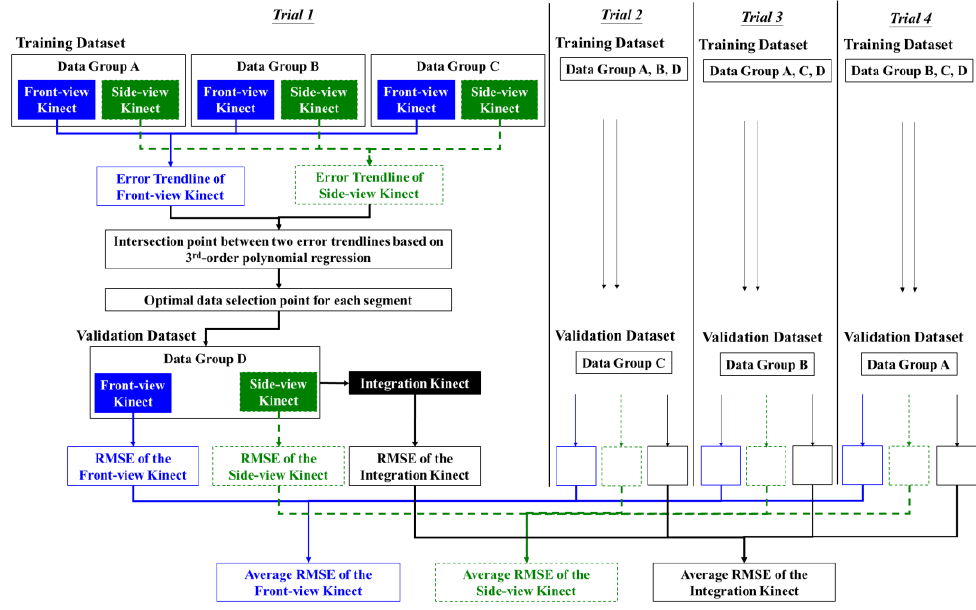
Figure 4. The framework to validate the proposed method.